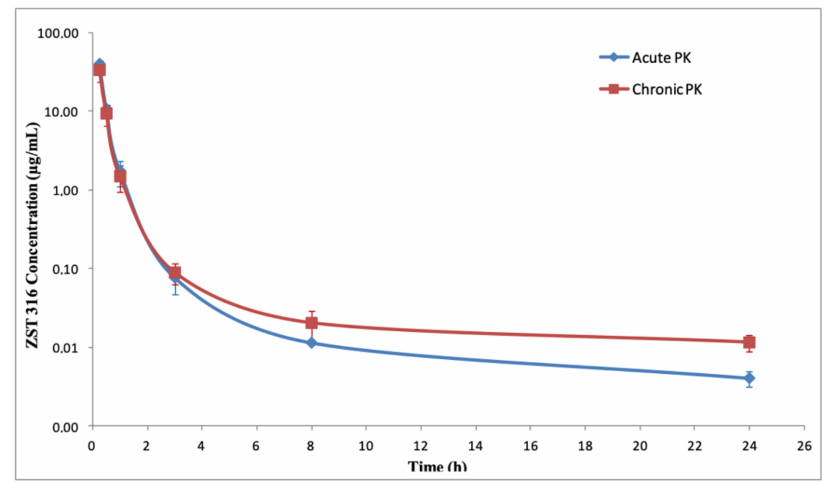
Figure 7. Plasma decay curves of ZST316 after acute and chronic intraperitoneal administration.